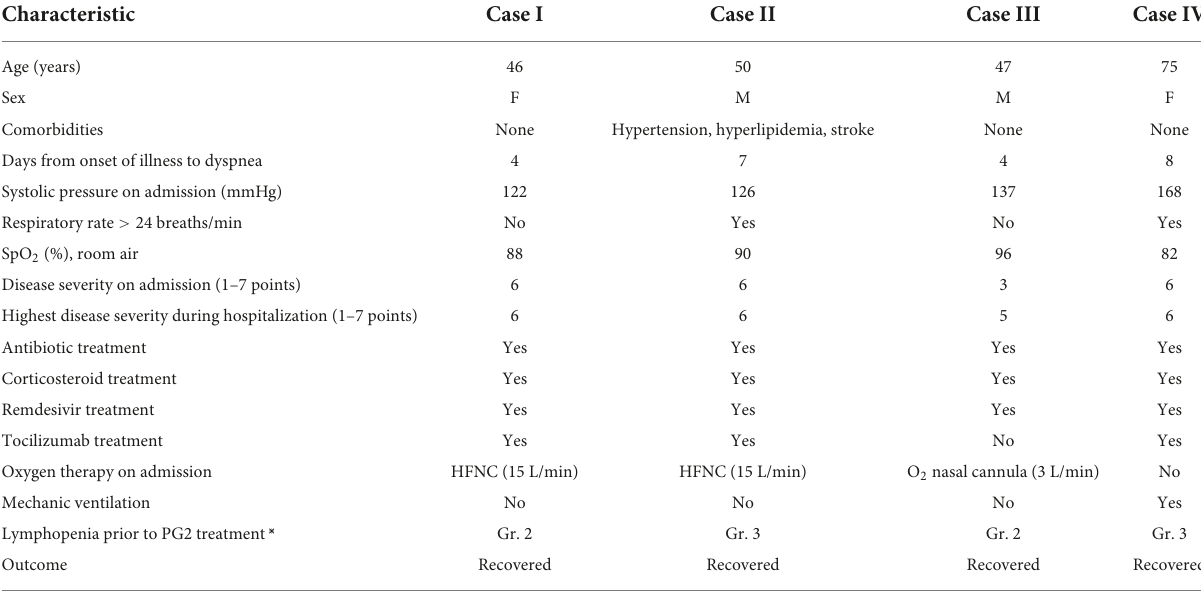
TABLE 2 Clinico-demographic data, treatment modalities, and outcomes of four patients with severe/critical COVID-19 infection who received PG2 treatment. Characteristic Case I Case II Case